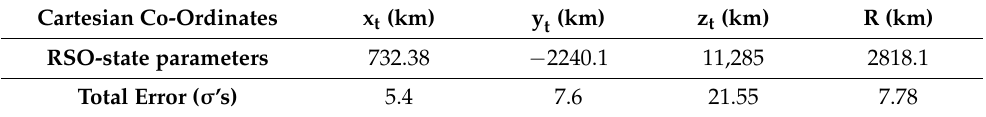
Table 7. RSO position estimates and the corresponding errors.